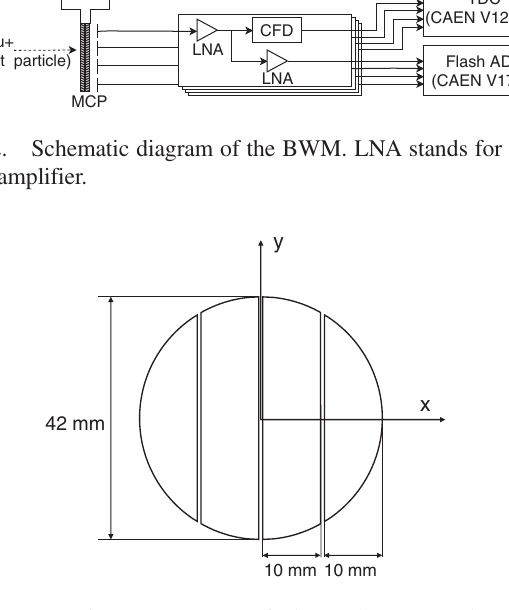
FIG. 3. Anode arrangement of the MCP. X- and y-axes correspond to the beam coordinate system.